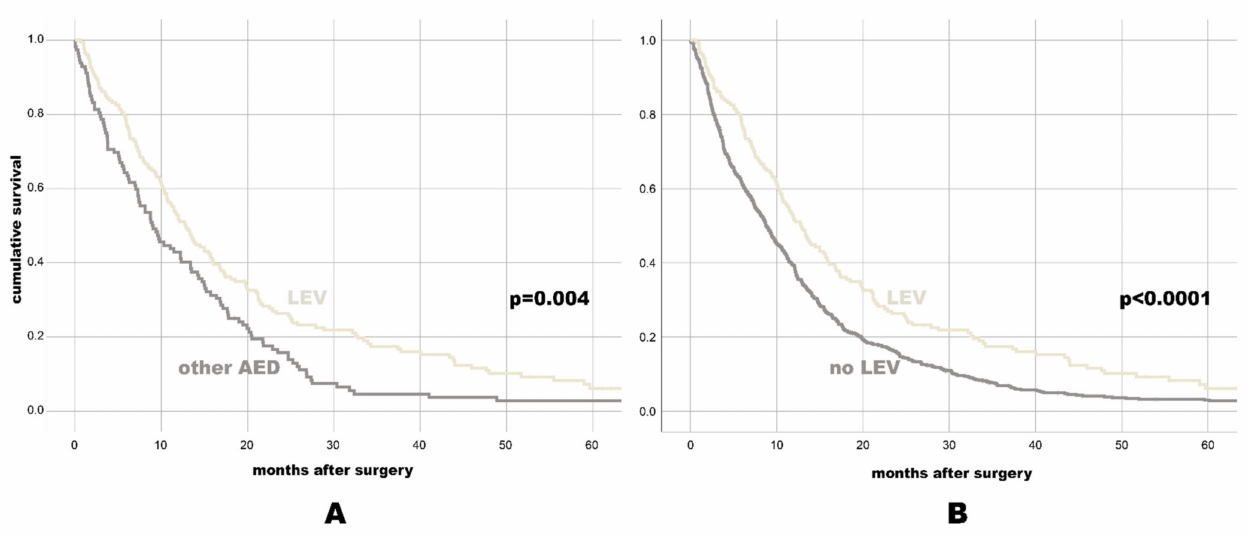
Figure 1. Kaplan-Meier-survival plot for OS for individuals with LEV vs. any other AED ( A ), and for individuals with LEV vs. No LEV ( B